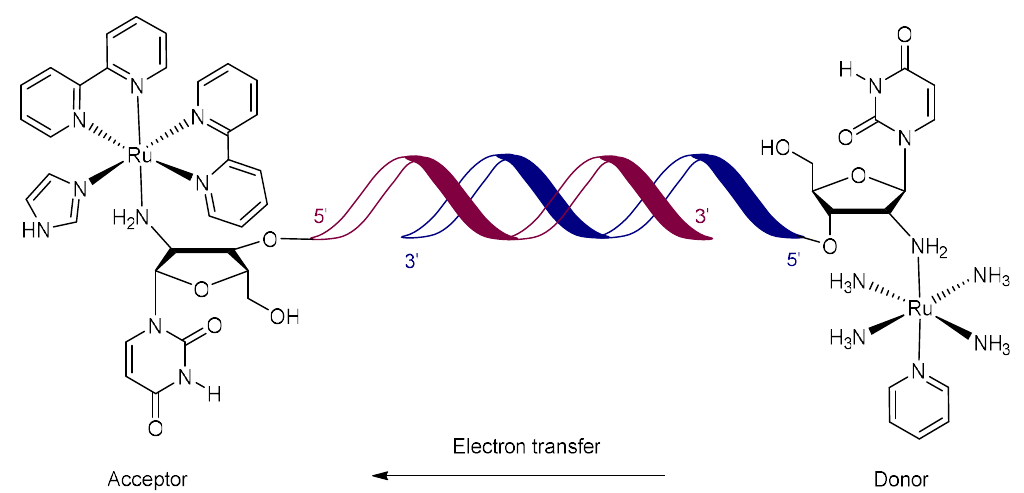
Figure 2. Structure of the duplex DNA (8- or 14-mer) containing ruthenium donor and acceptors [73]. Further long-range ET studies were completed by the group of Barton in 1997. A flash-quench strategy was employed to demonstrate ET through the DNA double helix [83]. Flash-quenching oxidation of guanine, the most readily-oxidised base [60,84–86]. In this experiment the DNA-bound intercalator [Ru(phen)(bpy’)(Me 2 dppz)] 2+ was photolysed to enable the ET to an externally bound